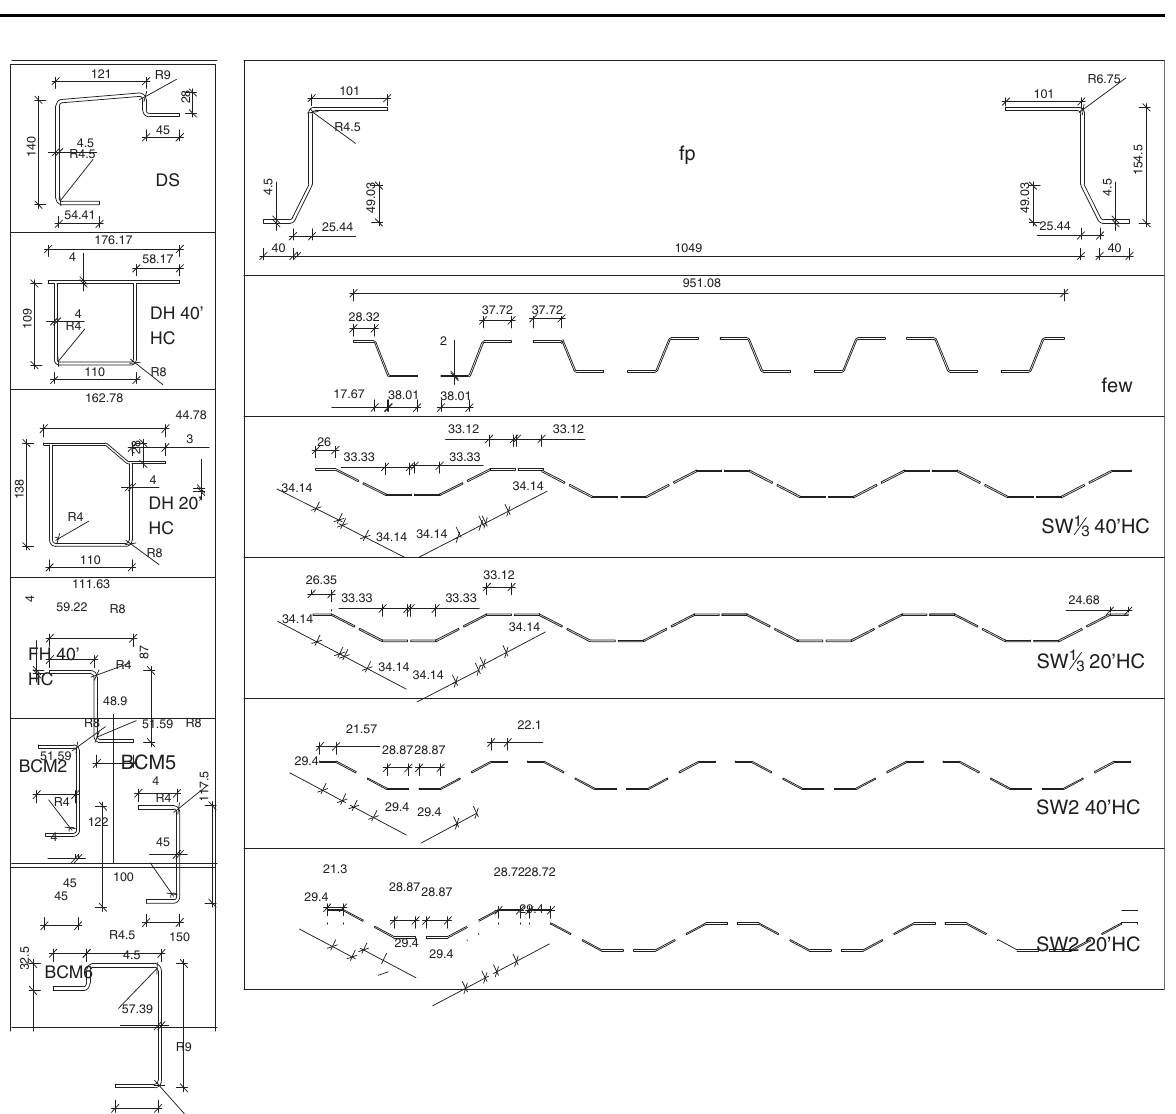
Table 9. Effective